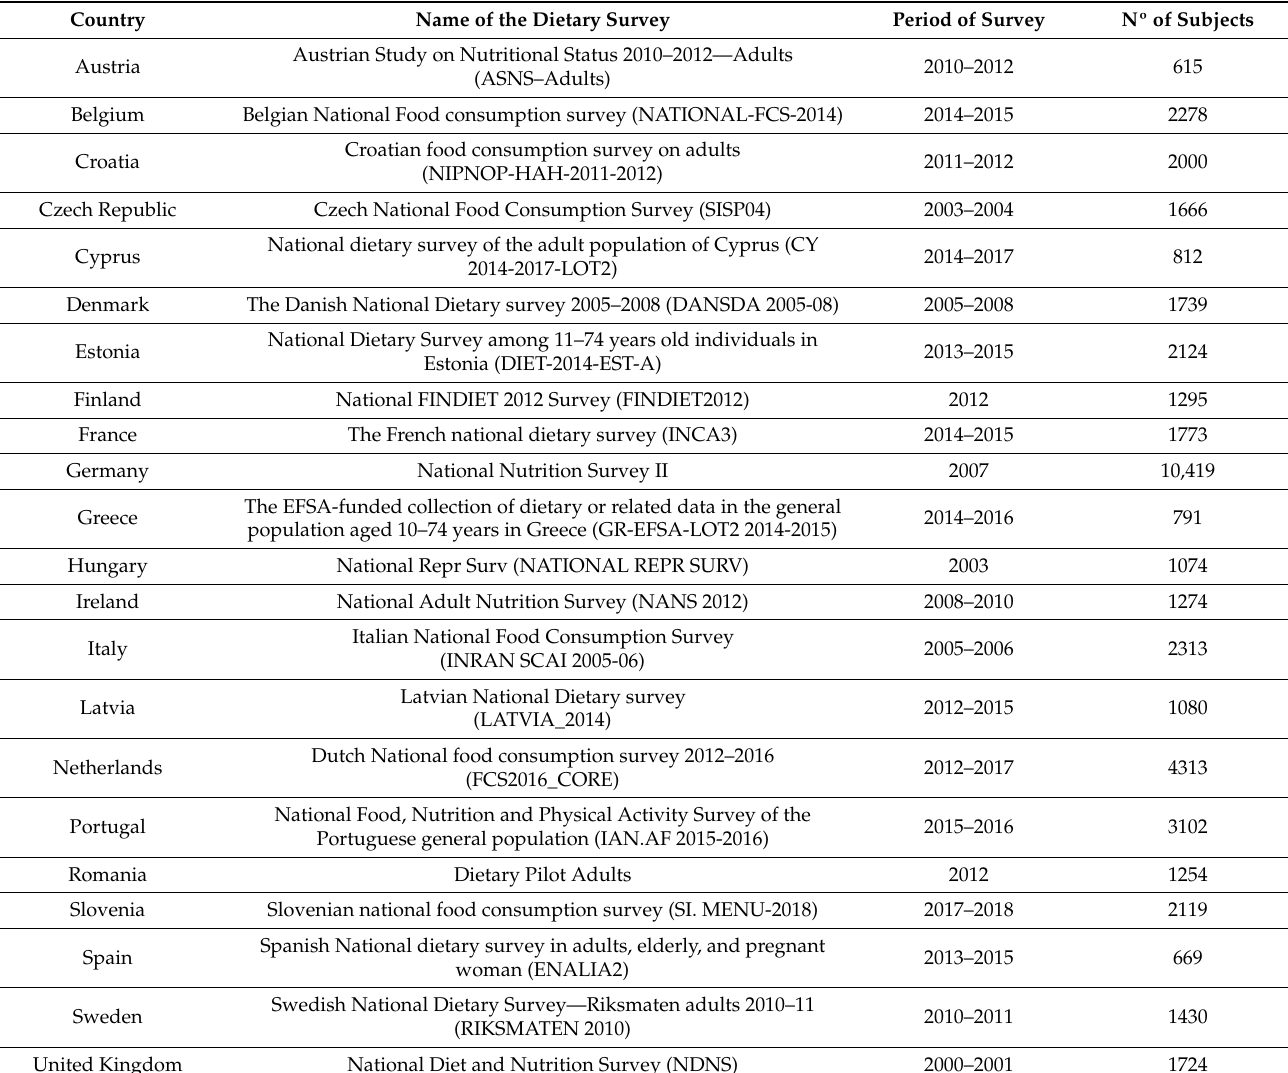
Table 4. Dietary surveys for the adult population in the European countries used in this study (EFSA Comprehensive European Food Consumption